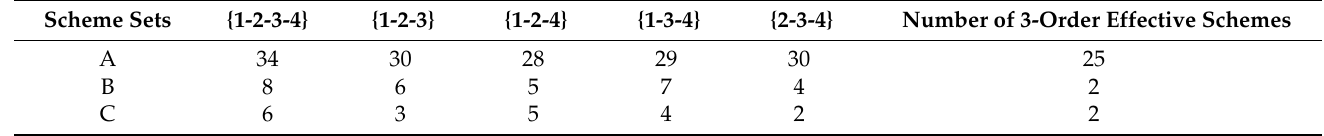
Table 3. Number of 4-order and 3-order effective schemes for different scheme sets.